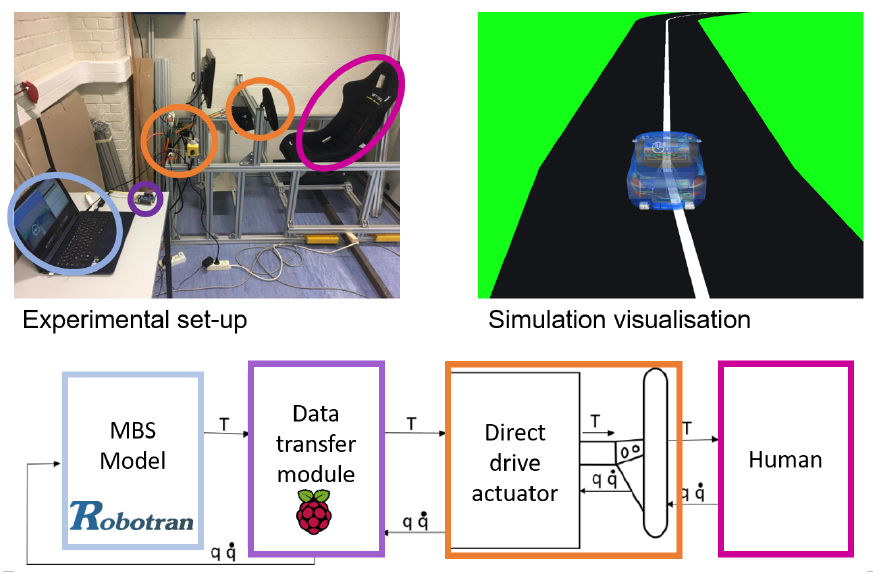
Figure 27. Haptic steering wheel: experimental setup with its real-time visualization and its corre- sponding block diagram below.